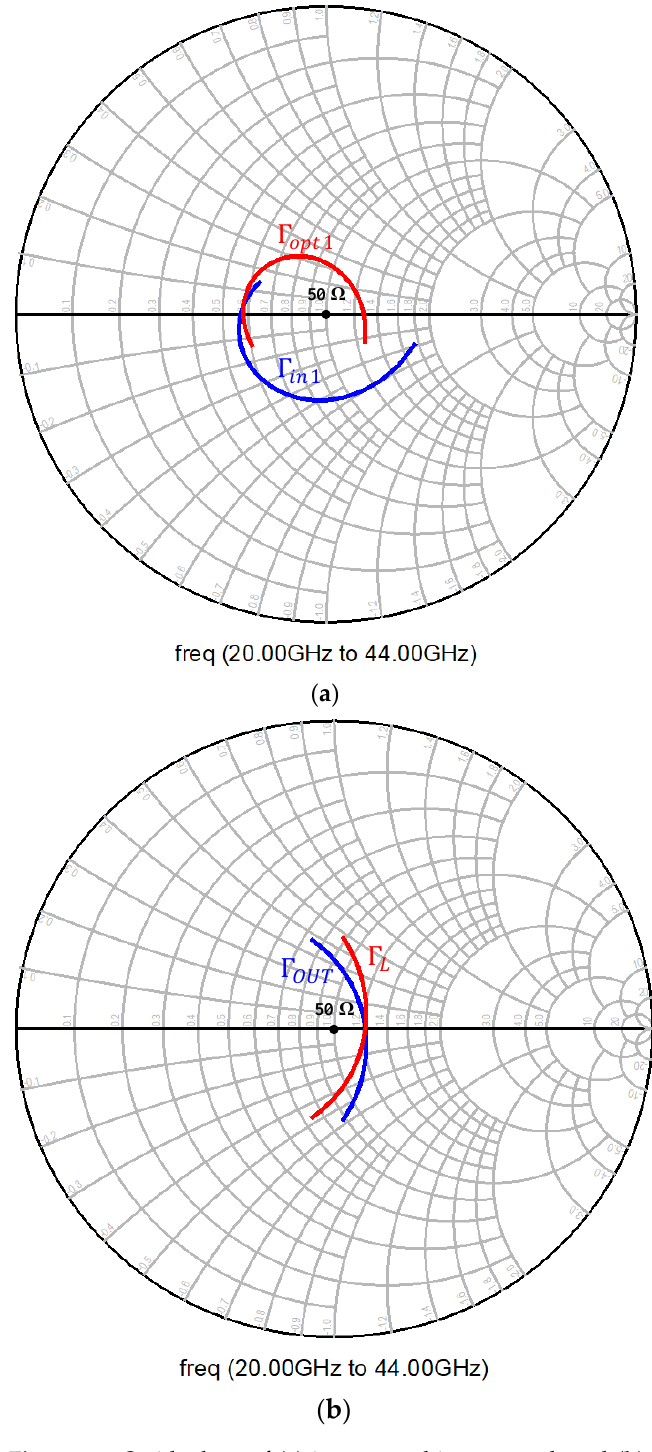
Figure 10. Smith chart of ( a ) input-matching network and ( b ) output-matching network over a frequency of 20 – 44 GHz.